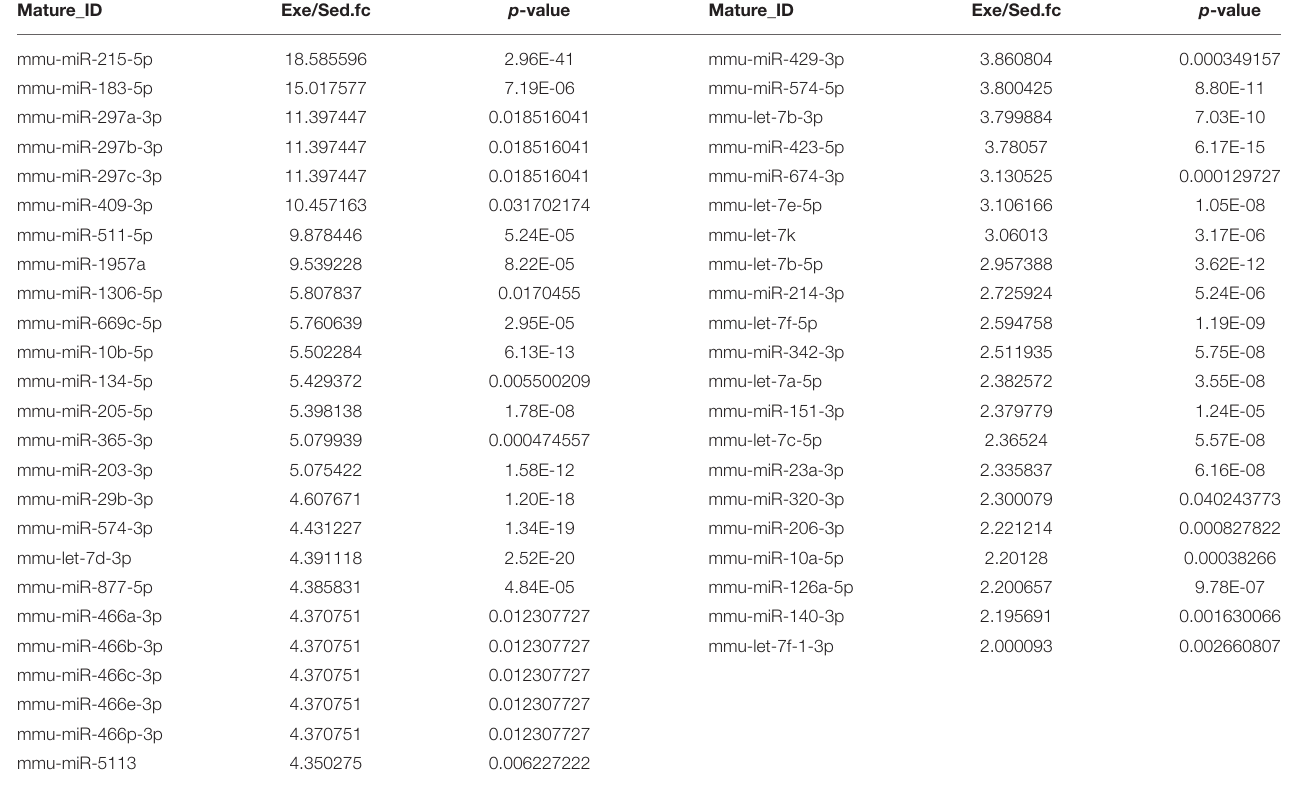
TABLE 2A | The list of upregulated miRNAs in 4 weeks of voluntary wheel exercise. Mature_ID Exe/Sed.fc p -value Mature_ID